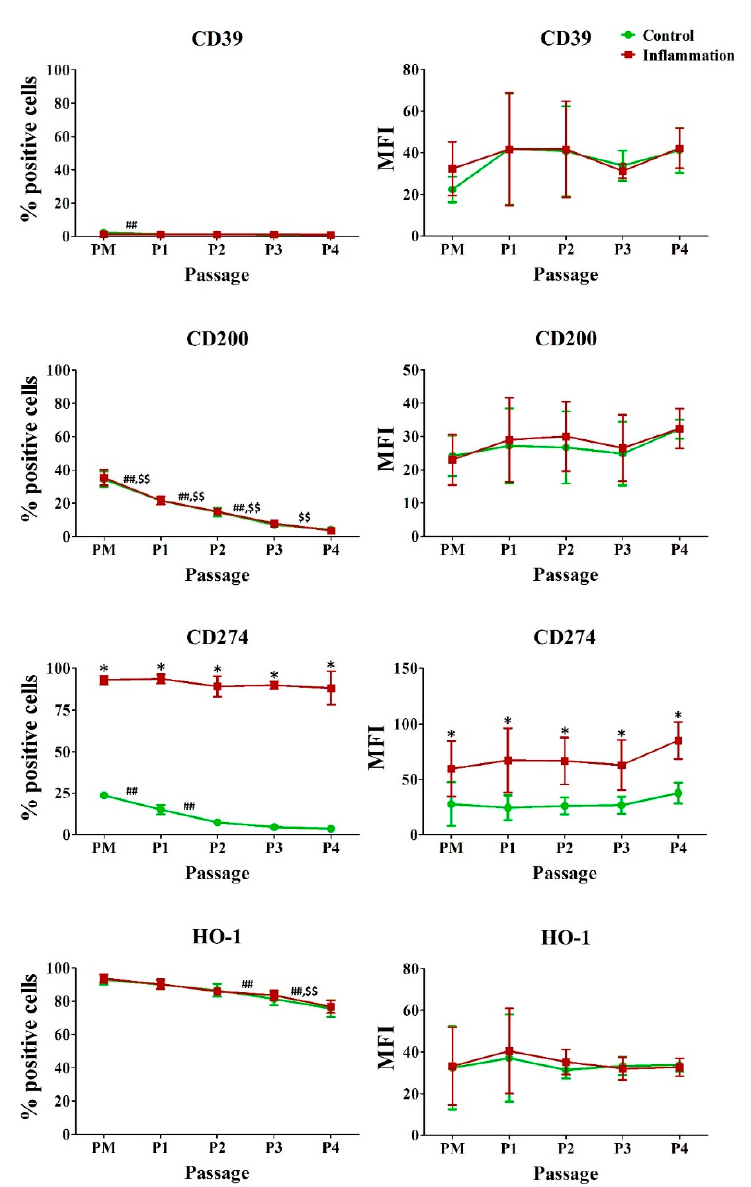
Figure 5. Impact of inflammation and cell passaging on the expression of immunoregulatory molecules in AT-MSCs. Flow cytometric analysis was used to determine the percentage of positive cells and the protein expression per cell (MFI). The values are expressed as mean ± SD and originate from six different AT-MSC donors. * Significantly higher percentage or amount per cell in inflammation-stimulated AT-MSCs compared to regular AT-MSCs ( p -value < 0.05). ## Significantly lower percentage or amount per cell in regular AT-MSCs compared to the consecutive passage ( p -value < 0.05). $$ Significantly lower percentage or amount per cell in inflammation-stimulated AT-MSCs compared to the consecutive passage ( p -value <